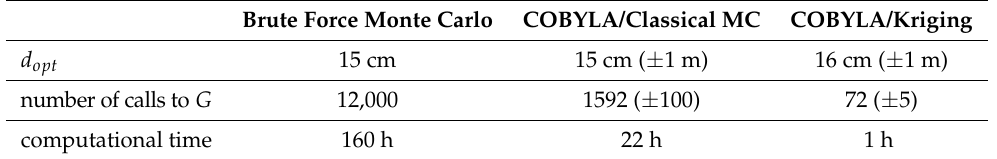
Figure 5. G function distribution: brute force analysis F ≈ 2 MHz and fixed heights of the bundles. Table 1. Brute force, COBYLA/classical MC, and COBYLA/Kriging methods with F ≈ 2 MHz and fixed heights of the